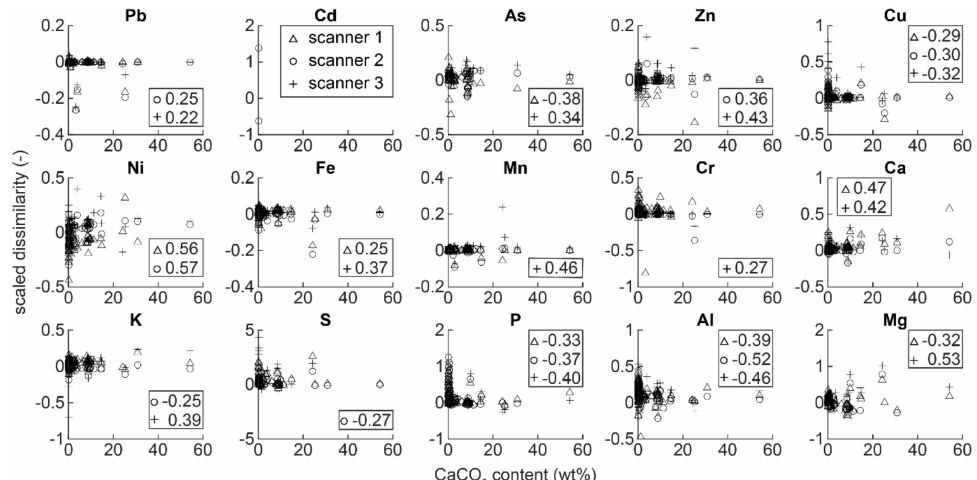
Figure 7. E ff ect of CaCO 3 on X-ray fluorescence (XRF) performance. Scatterplots of the scaled dissimilarities for all samples and all scanners versus the samples’ CaCO 3 contents. Significant (5% significance level) Spearman correlations between the scaled dissimilarities and the CaCO 3 contents are shown for each scanner.